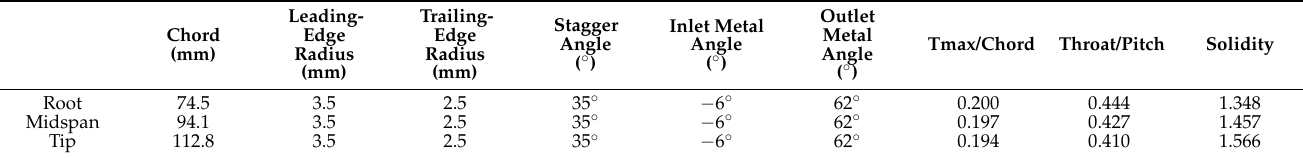
Figure 3. ITD design parameters of some turbofan engines [30]. Table 1. Design parameters of the integrated